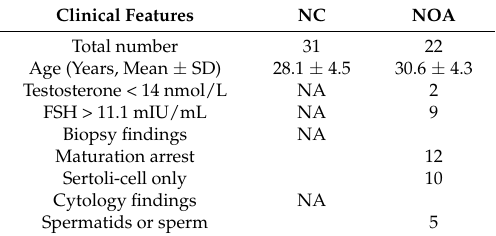
Table 1. Clinical features and biopsy results of azoospermic patients and normal subjects.